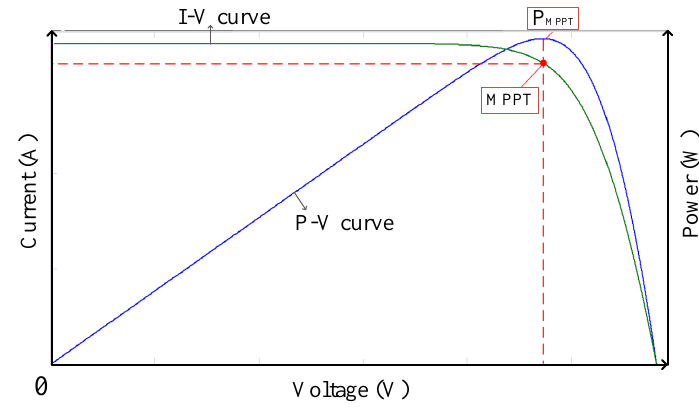
Figure 3. Characteristic curves of a typical PV